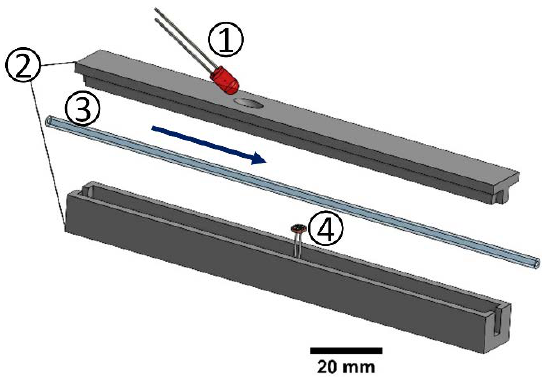
Figure 3. Exploded view of particle sensor: 1 = LED, 2 = 3D-printed housing, 3 = FEP tube, and 4 = photoresistor .